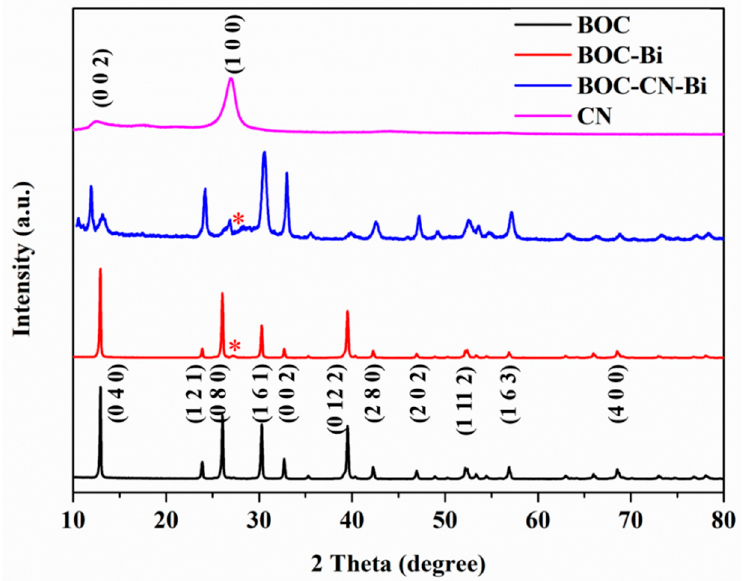
Figure 3. XRD patterns of BOC, CN, BOC-Bi and BOC-CN-Bi photocatalysts (* indicates peaks of metallic Bi).